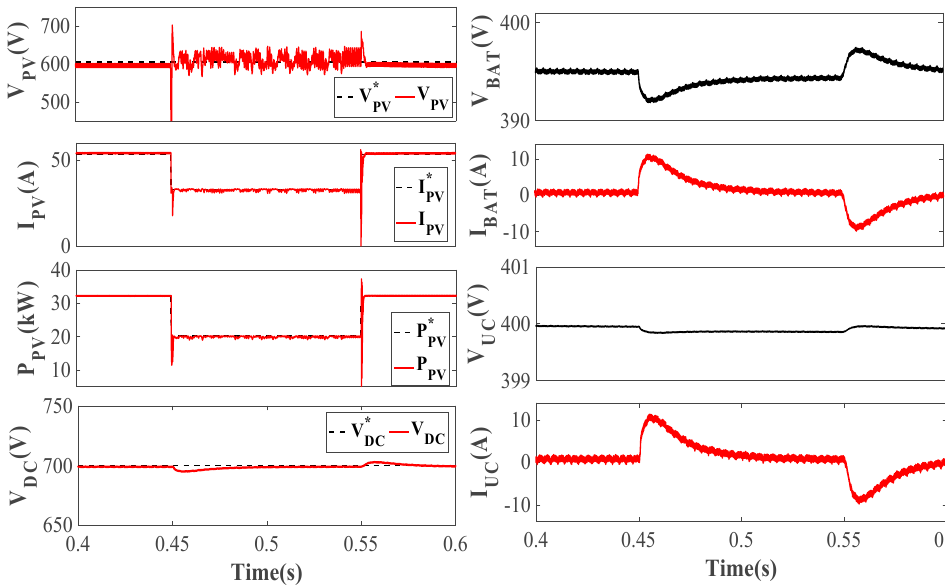
, (cid:2191) , (cid:2191) , (cid:2191) , (cid:2178) , (cid:2191) , (cid:2191) , (cid:2191) , (cid:2172) (cid:1801)(cid:1814)(cid:1804) (cid:2173) (cid:2175)(cid:2183)(cid:2184)(cid:2185) (cid:2175)(cid:2183)(cid:2184)(cid:2185) (cid:2168)(cid:2183) (cid:2159)(cid:2183) (cid:2186) (cid:2175)(cid:2196) (cid:2159)(cid:2196) (cid:2168)(cid:2196) (cid:2189) (cid:2189) .